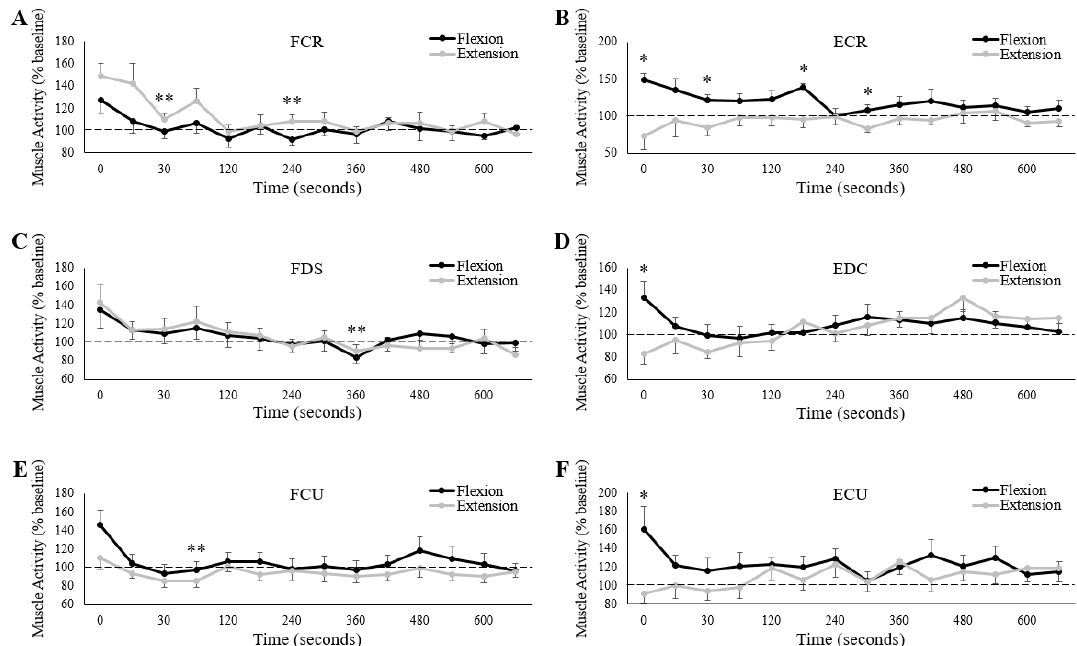
Figure 6. Group averages of normalized (% of baseline) pre-stimulus muscle activity for ( A ) FCR, ( B ) ECR, ( C ) FDS, ( D ) EDC, ( E ) FCU and ( F ) ECU. Black / grey lines are muscle activity collected on the wrist flexion / extension fatigue sessions, respectively. Horizontal dashed lines represent baseline (pre-fatigue) values. The x -axes denote time, with “0” representing the first measurement immediately after the cessation of the fatigue-inducing trial. All unlabeled points occurred 15 s after the preceding time point. * denotes a significant di ff erence between sessions at a single measurement point. ** denotes a significant di ff erence of a single measurement point (across both sessions) to “0”. Error bars represent standard